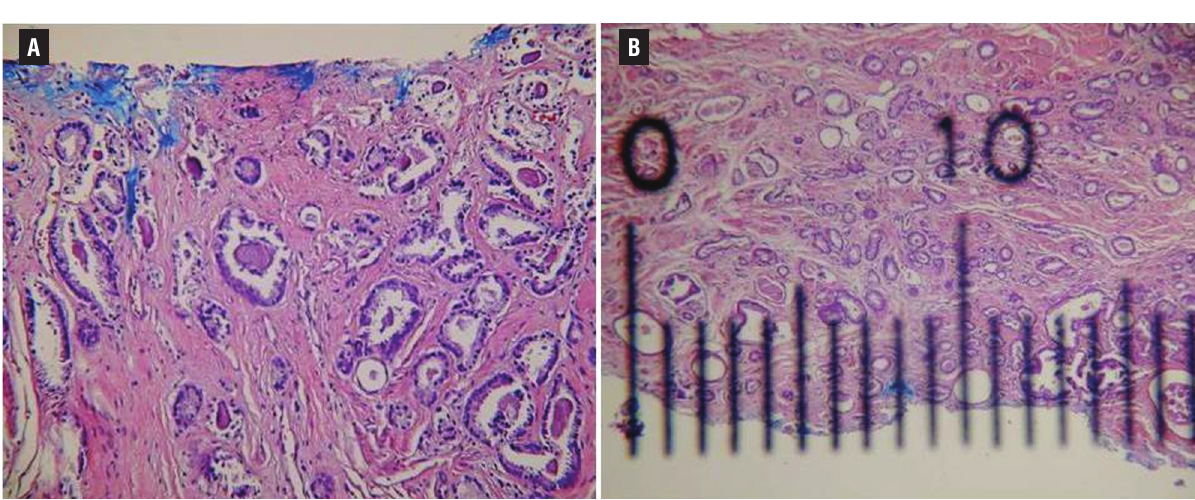
Figure 1 - A) Positive surgical margin with tumor glands inked with India ink. B) Micrometric ruler used to measure the extent of positive surgical margin and extra-prostatic